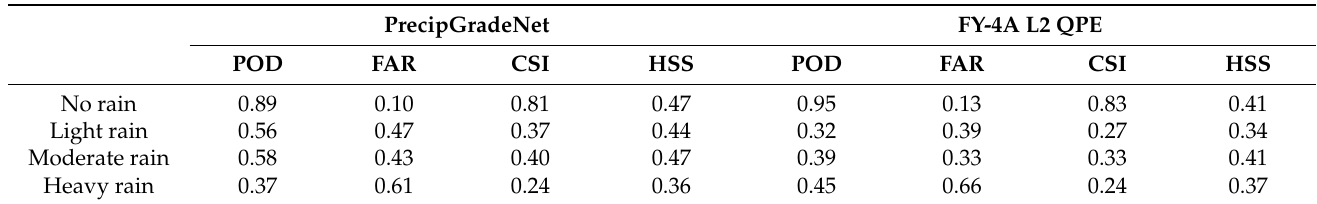
Table 10. Summary of the PrecipGradeNet and FY-4A L2 QPE detection performance for different precipitation intensity intervals during the evaluation period of 4 August 2021 to 7 October 2021, total 3,370,943 pixels. (Error within one precipitation intensity interval).